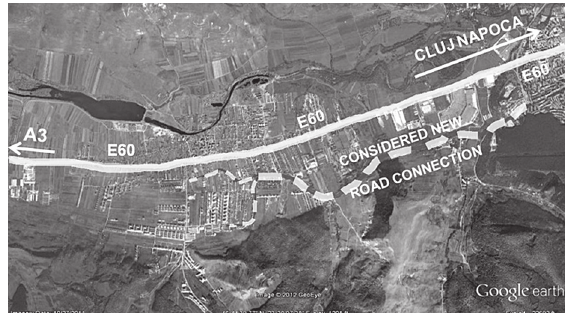
Fig. 8. Alternative scenario: development of a new road (in dashed